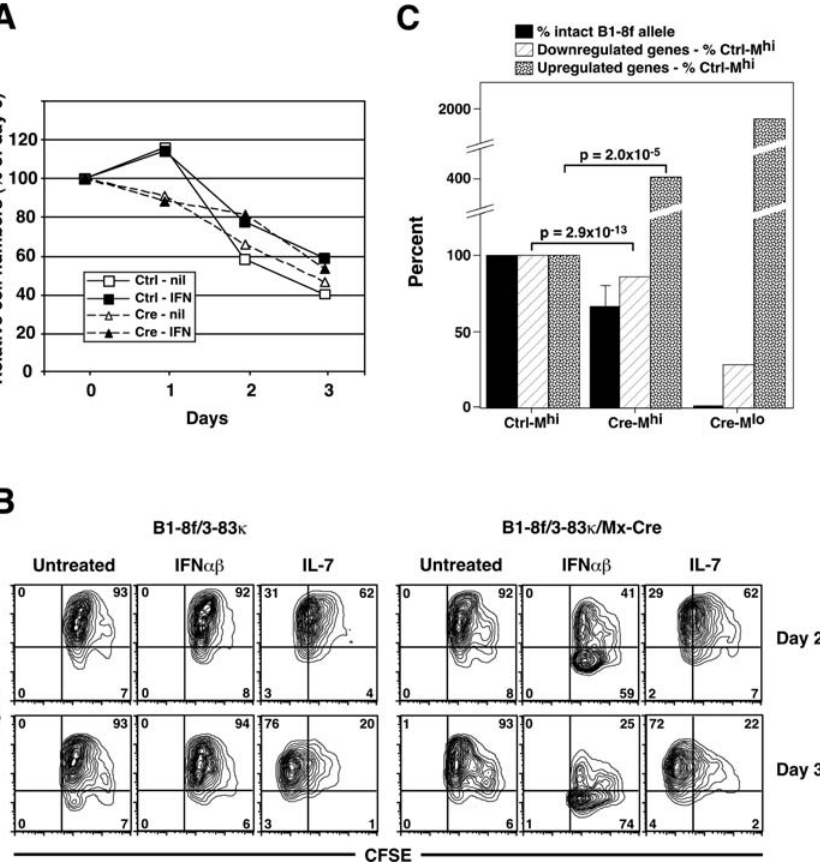
Figure 4. Gene Expression Phenotype of Cre-M hi Cell Populations Is Intermediate between Ctrl-M hi and Cre-M lo Populations (A) Viable cell counts were performed in control B1-8f/3-83 j and B1-8f/3-83 j /Mx-Cre cell populations at the initiation of culture with medium alone (nil) or with IFN ab (IFN) 1,000 units/ml, and daily for 3 d. Data are presented as percent of the day 0 cell numbers, and represent 4–7 experiments for each population. Standard errors were less than 10%, and are not shown. (B) BM cells were cultured for 5 d in IL-7, and were then labeled with CFSE and incubated with 1,000 units/ml IFN ab or, as a proliferation control, 16 ng/ml IL-7 for an additional 3 d. Flow cytometric analysis of CFSE dye dilution of B220 þ cells indicated no significant proliferation of IFN-treated cell populations. Numbers represent percent of gated cells. (C) A PCR-based assay was used to quantitate the extent of B1-8f deletion in Ctrl-M hi , Cre-M hi , and Cre-M lo populations. Ctrl-M hi cells contained 100% intact B1-8f alleles, Cre-M lo cells were 100% deleted, and Cre-M hi cells had 34 6 16% average deletion of the B1-8f allele. Expression values for the Ctrl-M hi transcripts (significantly different between Ctrl-M hi and Cre-M lo ) were normalized to 1, and relative expression levels of transcripts up- ( n = 184) and down-regulated ( n = 143) in the three populations were calculated. In both groups of genes, Cre-M hi cells showed intermediate levels of gene expression between Ctrl-M hi and Cre-M lo , indicating that Cre-M lo cells originated from the Cre-M hi population. DOI: 10.1371/journal.pbio.0030082.g004